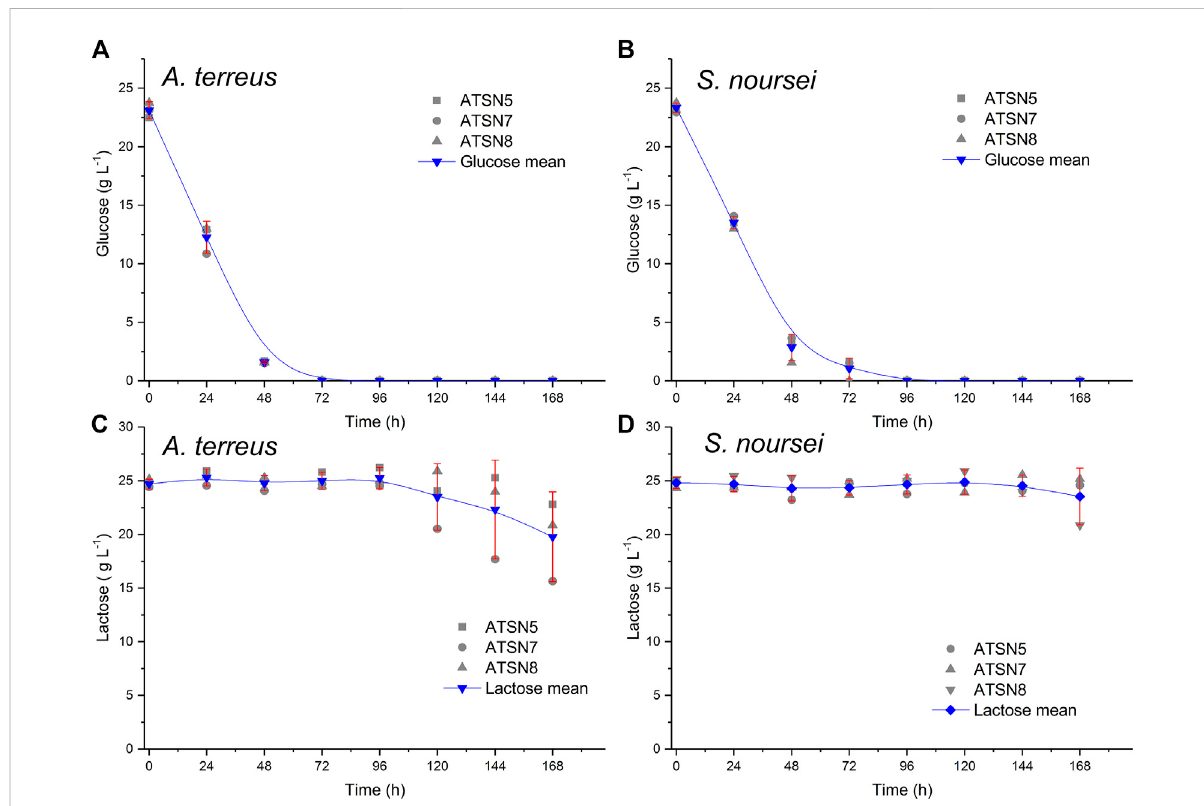
FIGURE 1 Replicabilityanalysisofglucose (A,B) andlactose (C,D) concentrationvaluesdeterminedoverthecourseofthestudyforthe A.terreus (A,C) and S. noursei (B,D) monocultures. The replicability was tested with the use of the con fi dence function in OriginPro 2017 software (OriginLab, United States) which returns the con fi dence interval for the mean value. Calculations were carried out for the signi fi cance level α = 0.05 based on three bioreactor experiments conducted in the same conditions, namely the monocultures in ATSN5, ATSN7 and ATSN8